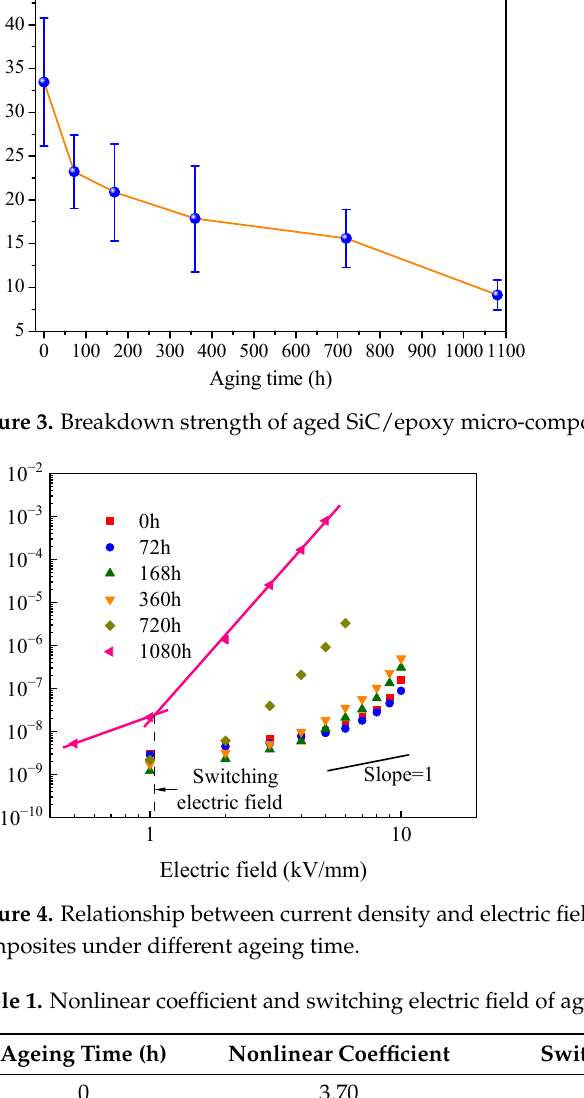
Figure 3. Breakdown strength of aged SiC/epoxy micro-composites.